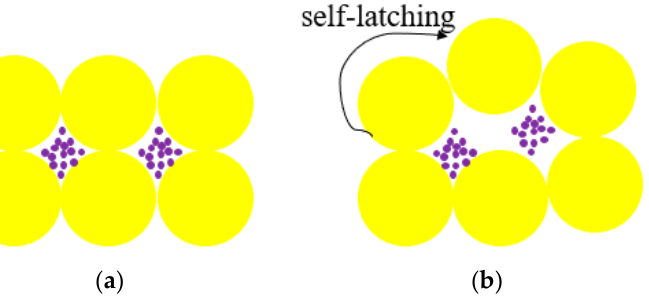
Figure 13. The shear mechanism between soil particles in natural gas hydrate-bearing sediments: ( a ) Before the shear, ( b ) After the shear.